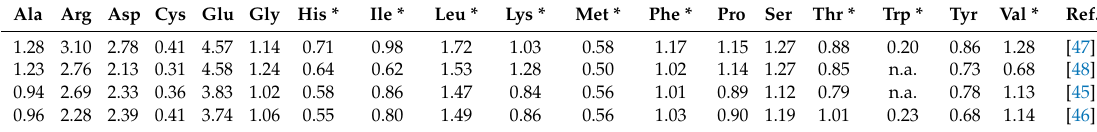
Table 6. Hempseed protein amino acid content (g / 100 g seed). Ala Arg Asp Cys Glu Gly His